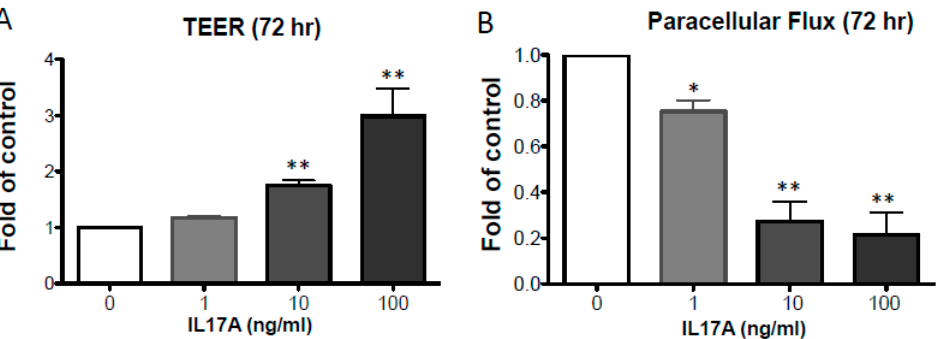
Figure 1. IL-17A enhances epidermal TJ barrier integrity. In PHK, IL-17A dose-dependently ( A ) enhanced TEER ( n = 3–6) and ( B ) reduced paracellular flux of fluorescein ( n = 3) 72 h after cytokine treatment. Data are shown as mean ± SEM fold of control. Significance was calculated compared to untreated controls. * p ≤ 0.05, ** p ≤